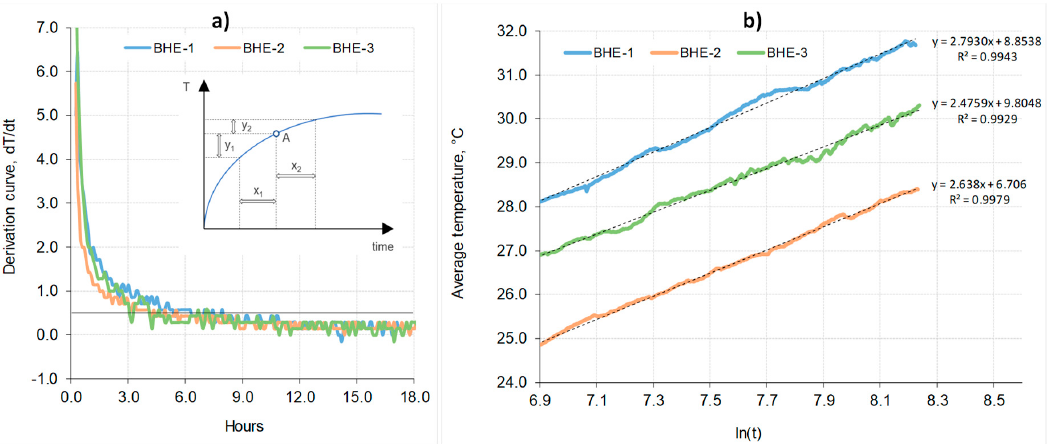
Figure 6. Determination of semi-steady state heat flow period ( a ) and determination of ground heat conductivity ( b ).